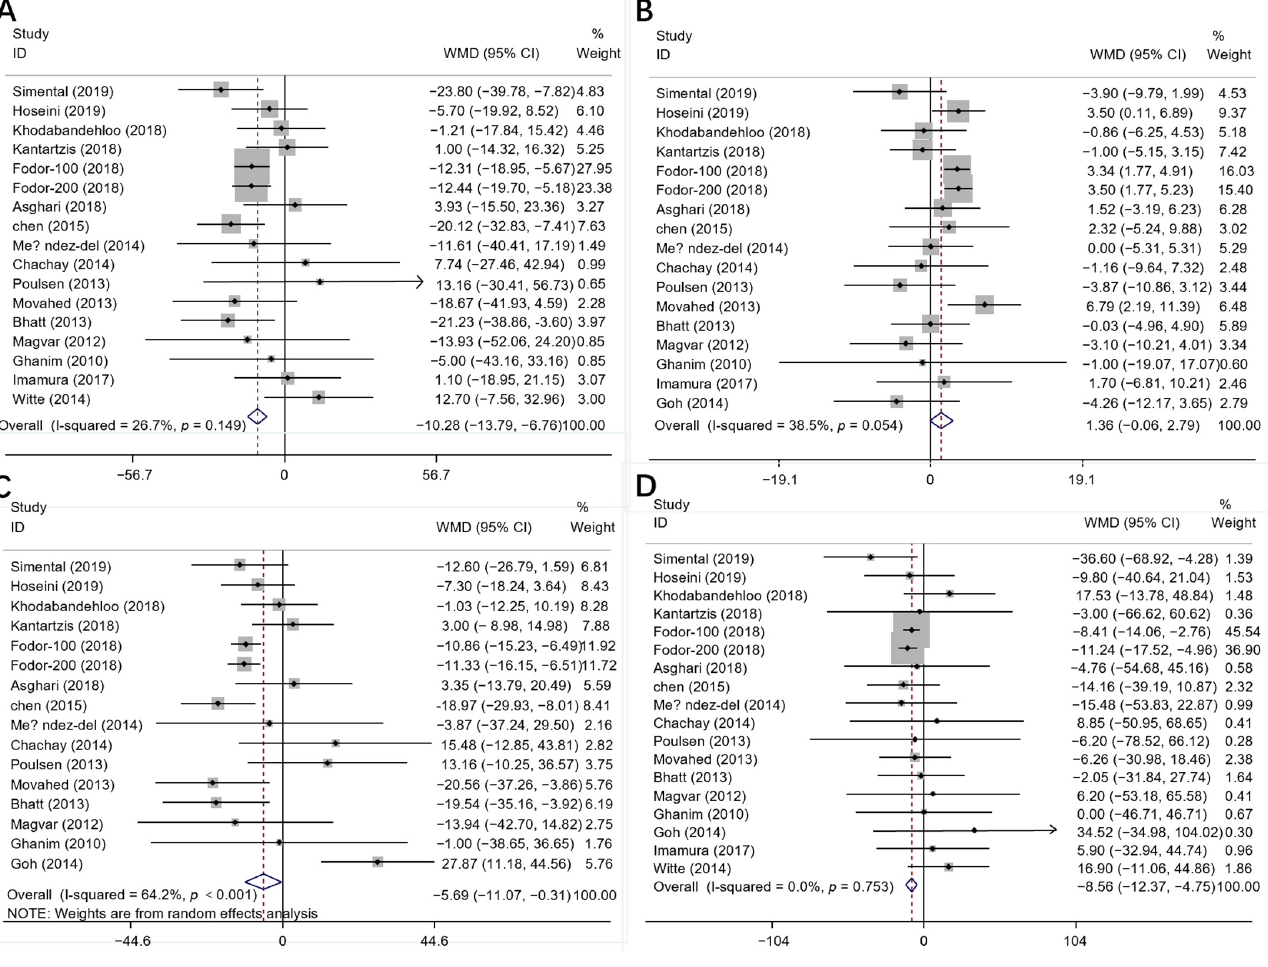
Figure 2. The effects of resveratrol on ( A ) TC, ( B ) HDL-C, ( C ) LDL-C and ( D ) TG. TC = Total choles- terol; LDL-C = Low-density lipoprotein cholesterol; HDL-C = High-density lipoprotein cholesterol; TG = Triglyceride; WMD = Weighted mean difference[19–27,32,35–41].